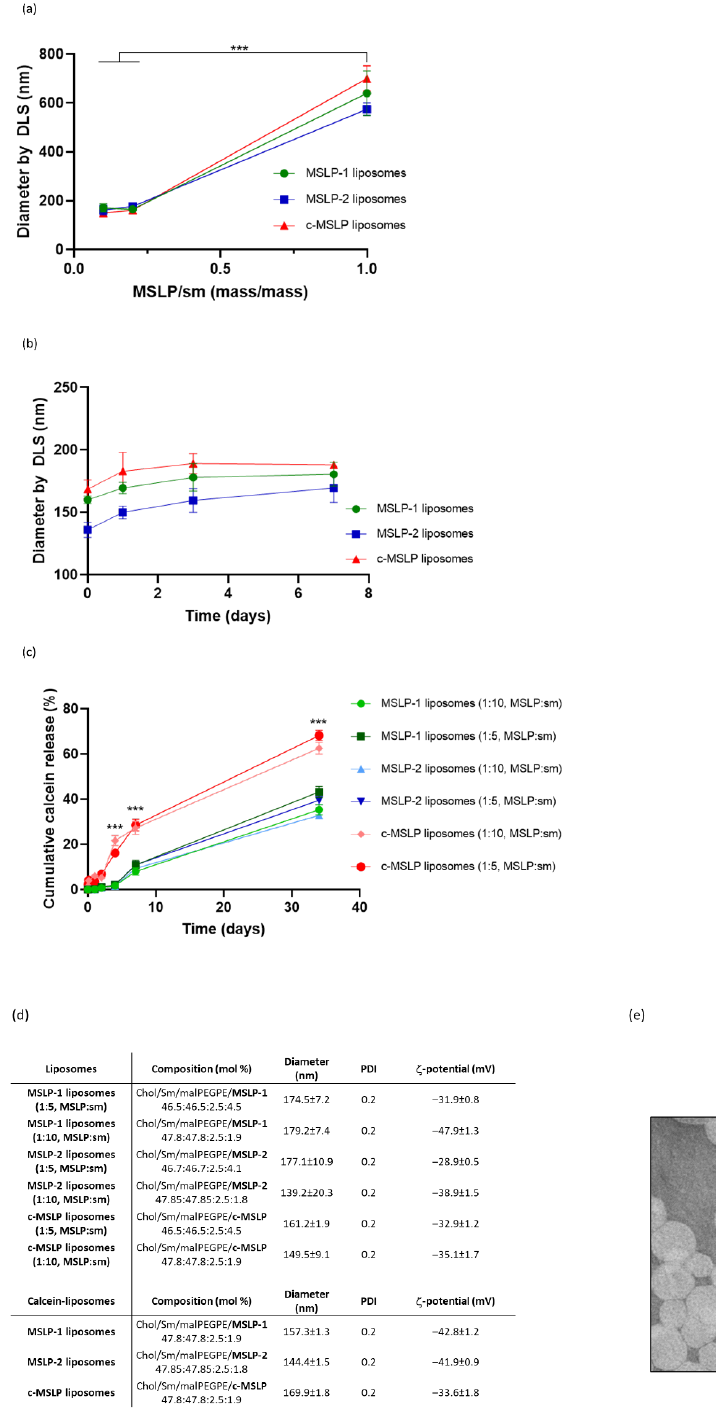
Figure 3. Characterization of MSLP-liposomes. ( a ) Hydrodynamic diameter of MSLP-liposomes prepared with different MSLP/Sm mass ratios, measured by DLS. ( b ) Hydrodynamic diameter of MSLP-liposomes measured by DLS at different time points. Dotted lines, 1:5 MSLP:Sm (mass/mass); continuous lines, 1:10 MSLP:Sm (mass/mass). ( c ) Cumulative calcein release from MSLP-liposomes. Inset: calcein release at short time points. Dotted lines, 1:5 MSLP:Sm (mass/mass); continuous lines, 1:10 MSLP:Sm (mass/mass). ( d ) Diameter, polydispersity index (PDI) and ζ -potential of MSLP- liposomes, empty or embedding calcein, measured by DLS and ZetaPALS device. ( e ) Representative TEM image of MSLP-liposomes (scale bar 200 nm). Results are expressed as mean ± SD ( n = 10). *** p < 0.001 (Student’s t